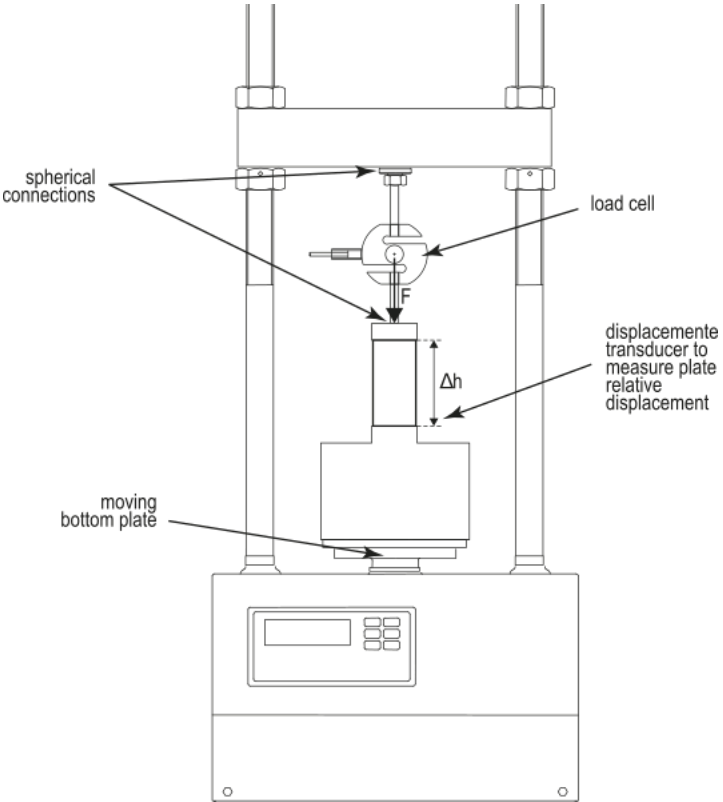
Figure 3. Schematic representation of the UCS test equipment, load frame and sensors.